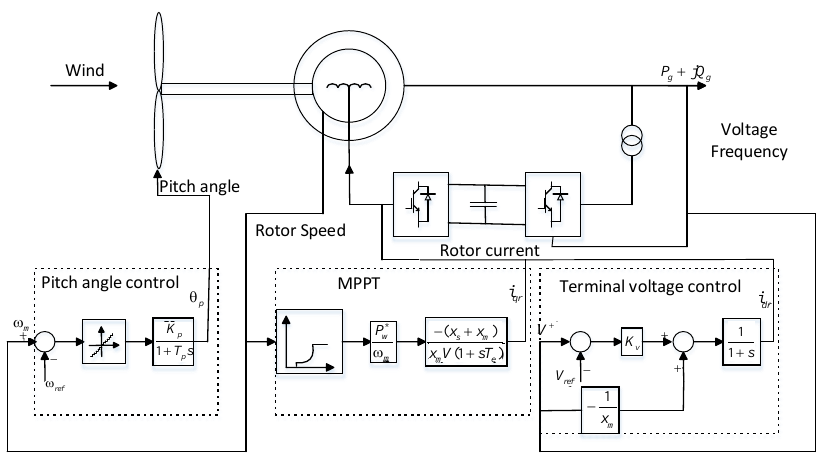
Figure 1. Structure of the DFIG control system.